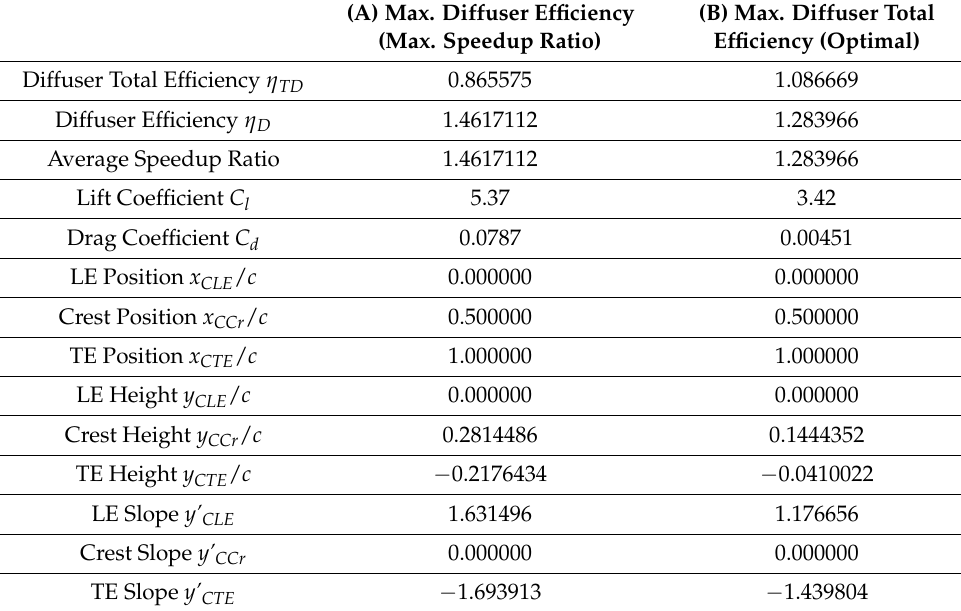
Table 2. Optimization results ( c : chord length of the diffuser).